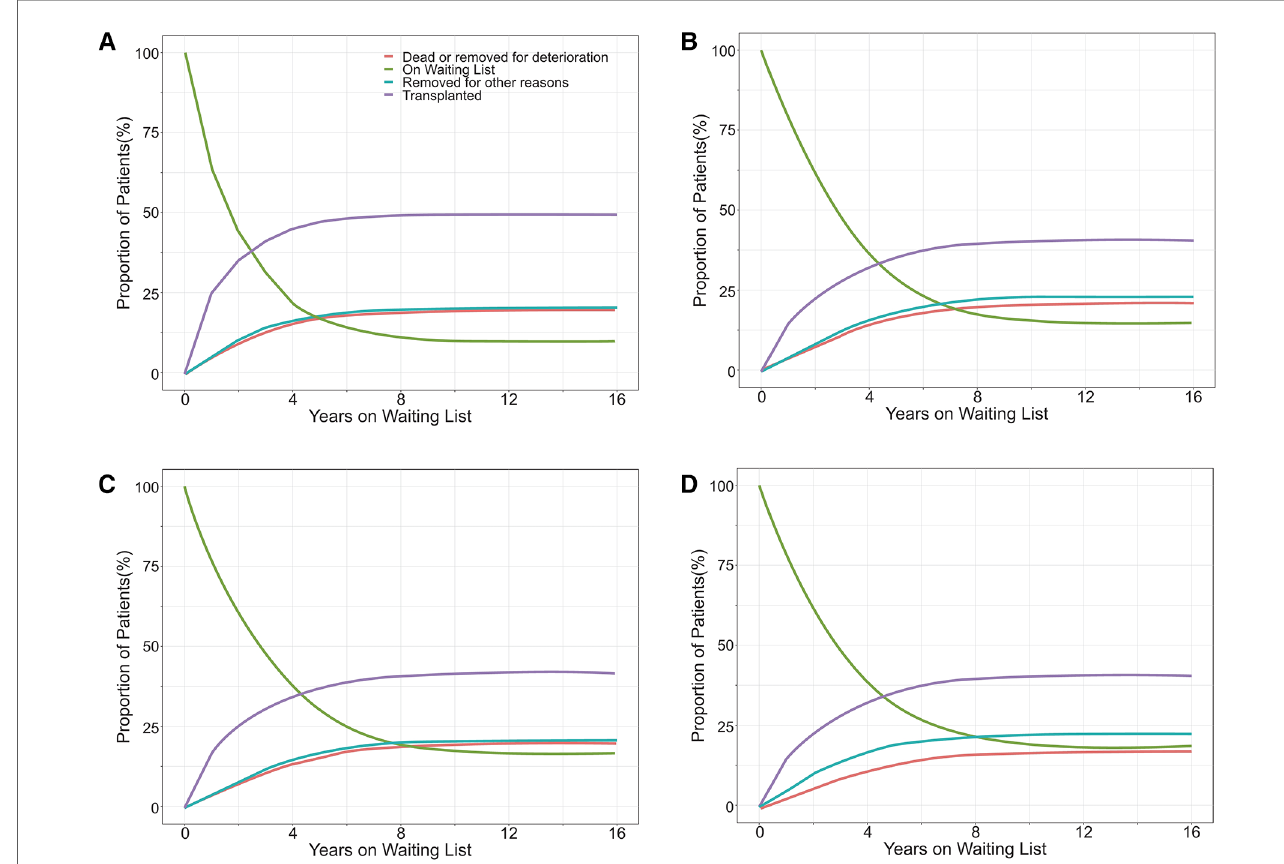
FIGURE 2 The proportion of outcomes for white ( A ), black ( B ), Hispanic ( C ), and Asian ( D ) patients listed for a kidney transplant in the United States.